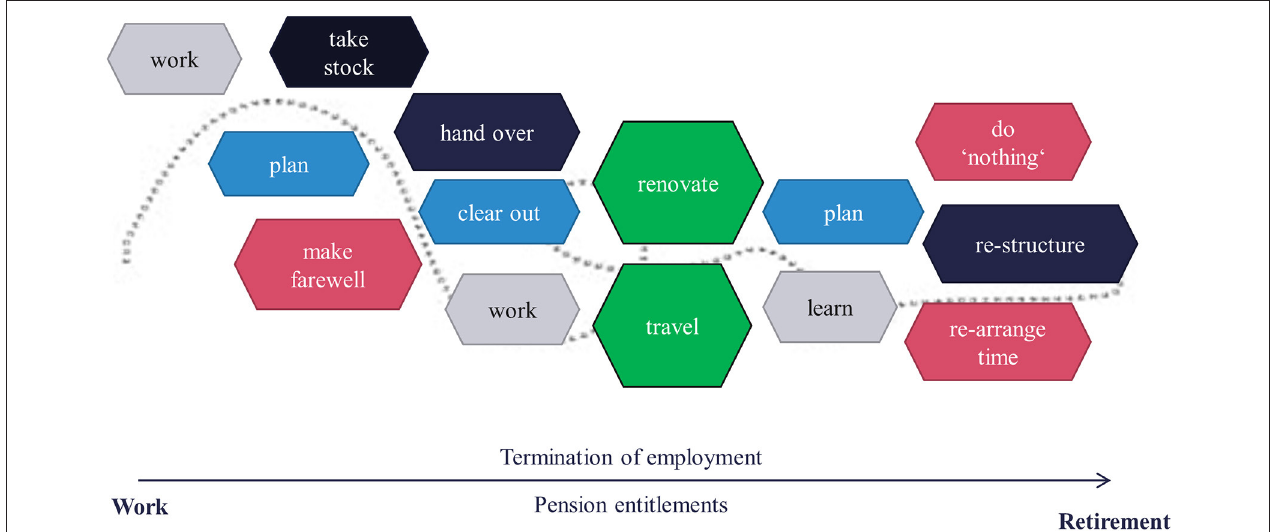
FIGURE 1 | Social practices of retiring; typical sequences for older adults retiring